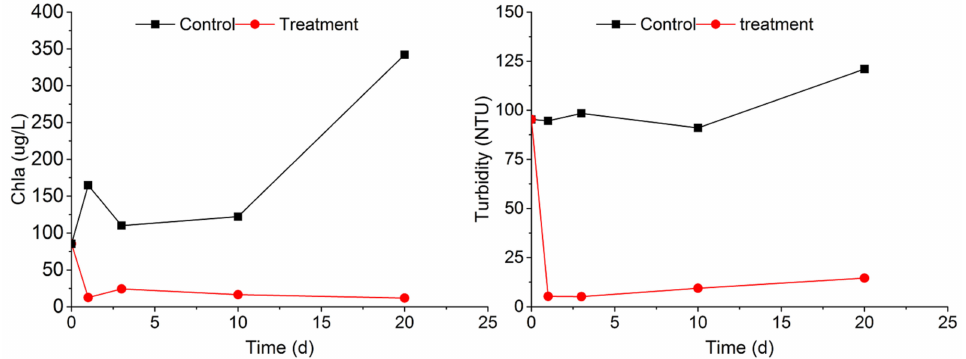
Figure 6. Chl- α concentration and Turbidity changes in the control and treatment ponds.